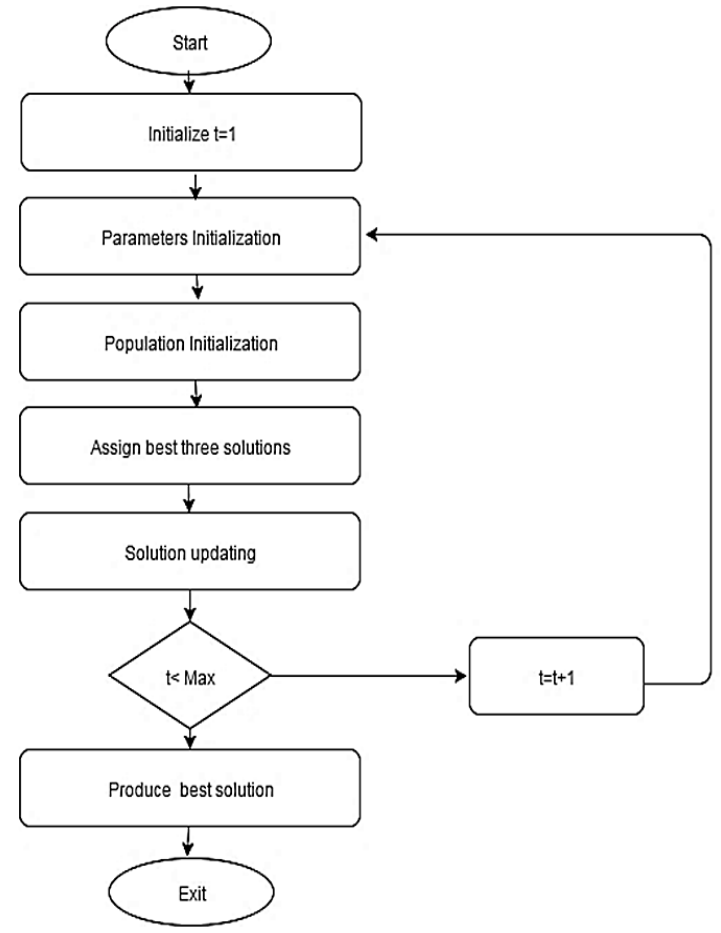
Figure 6. Flow diagram of the proposed algorithm.